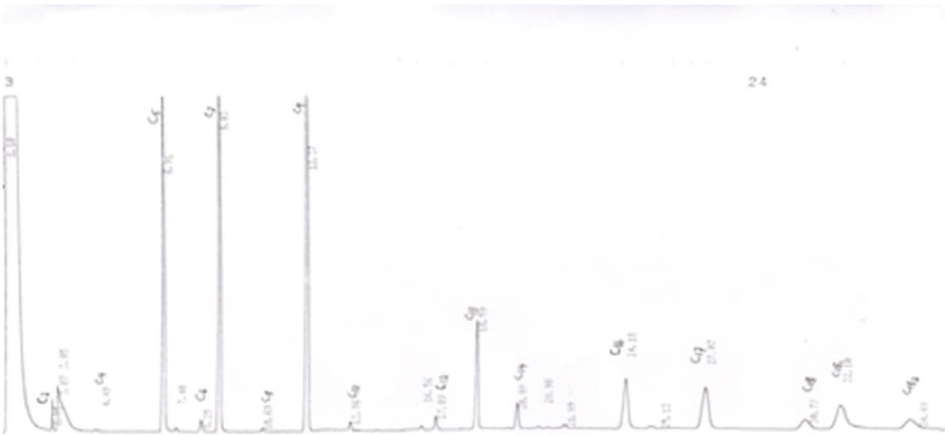
Figure 1: Gas chromatogram of FFA extracted from a UF white cheese (70 d old) spiked with internal FFA standards C and C 17:0